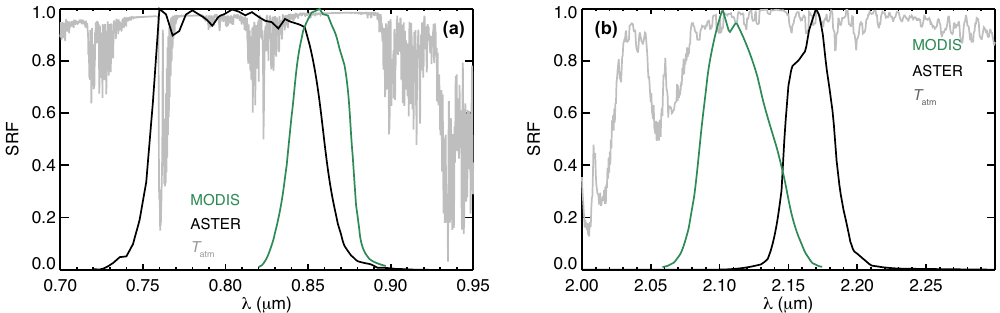
Figure 1. (a) Spectral response function (SRF) of the VNIR band signal for MODIS (green) and ASTER (black) as a function of wavelength ( λ ). Gray lines indicate the atmospheric transmittance T atm , calculated for the US 1976 Standard Atmosphere assuming a nadir-viewing geometry and a solar zenith angle of θ 0 = 0 ◦ . (b) Same as (a) but for the signal in the SWIR